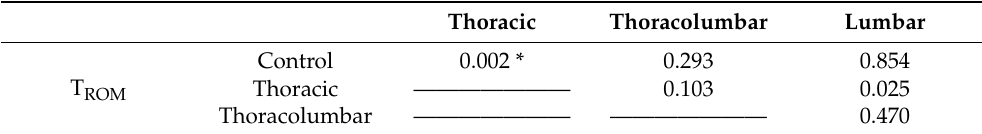
Table 6. p -Values of the multiple comparison test of T ROM of thoracic, thoracolumbar, and lumbar AIS patients and controls.